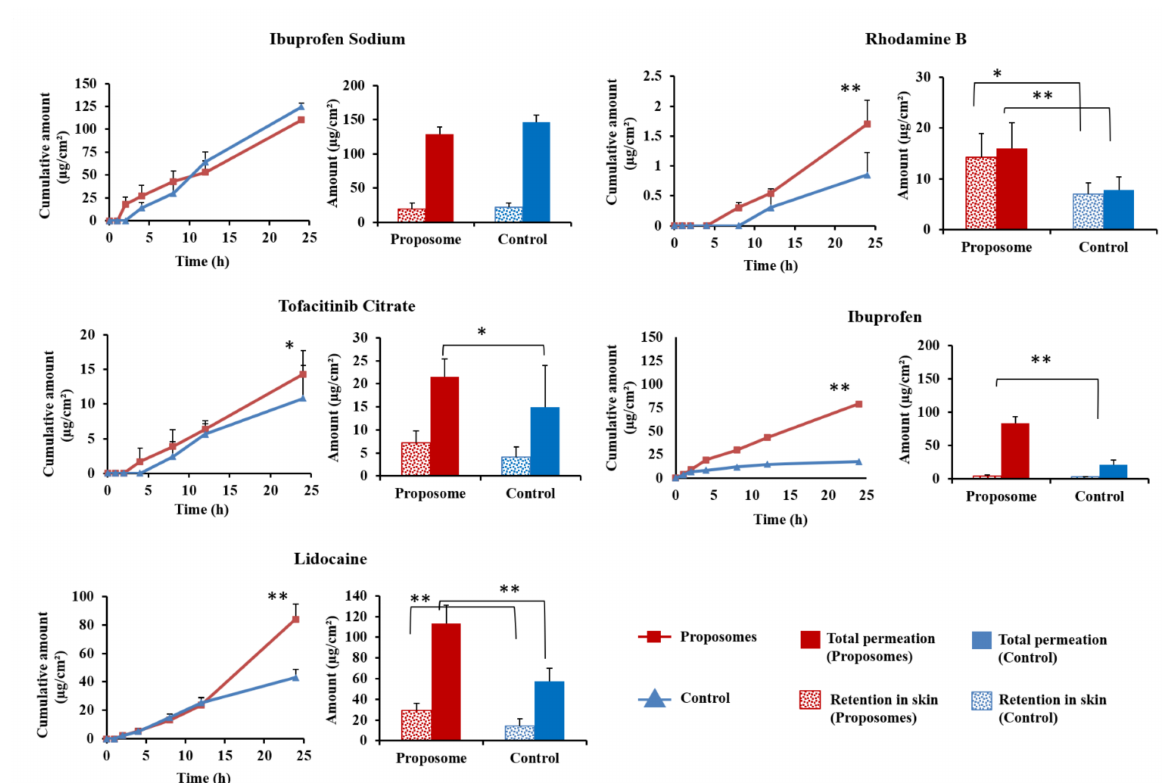
Figure 4. Skin permeation of proposomes and control for 24 h; drug retention in skin and the sum of permeated and retained. ** indicates statistically significant difference between proposome and control with p -value < 0.01. * indicates statistically significant difference with p -value <